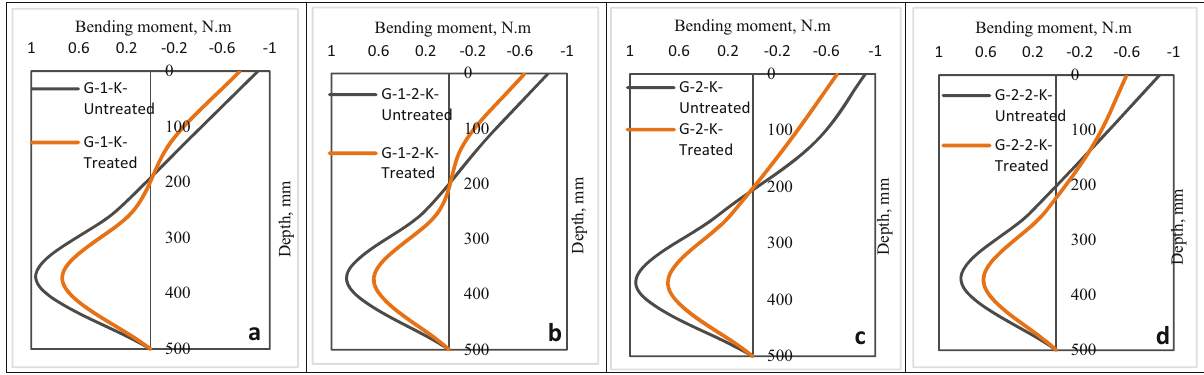
Figure 7: Bending moment of the pile group in the treated and untreated soil with nano - clay – P2 at ( a ) 50% axial load, ( b ) 50% axial load and 100% lateral load, ( c ) 100% axial load, and ( d ) 100% axial load and 100% lateral load.